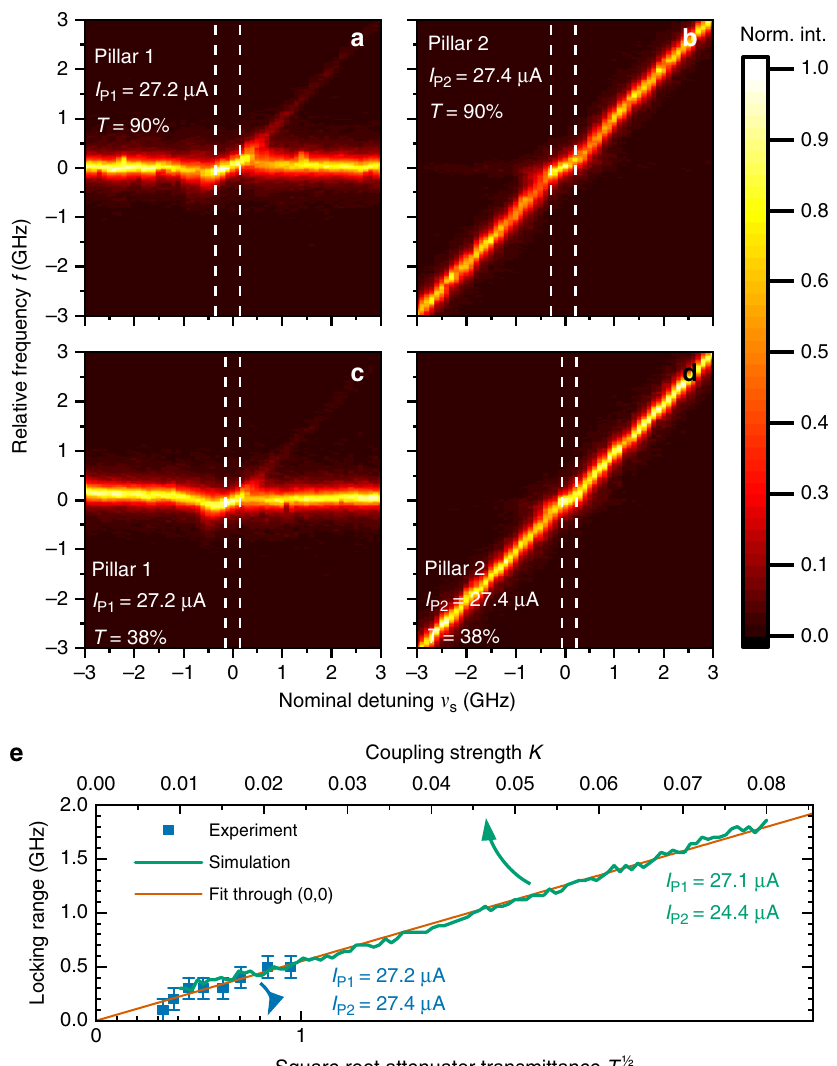
Fig. 3 Mutually coupled strong modes of the two micropillar lasers for different coupling strengths. a Detuning scans of the strong modes with high (panels a and b ) and low (panels c and d ) coupling strengths K . T is the transmittance of the attenuator in the coupling path. e Dependence of the locking range on the square root of the attenuator transmission (lower axis) and the coupling strength K used in numerical simulations (upper axis). The horizontal axes are scaled such that experimental and simulated data both lie on a common linear